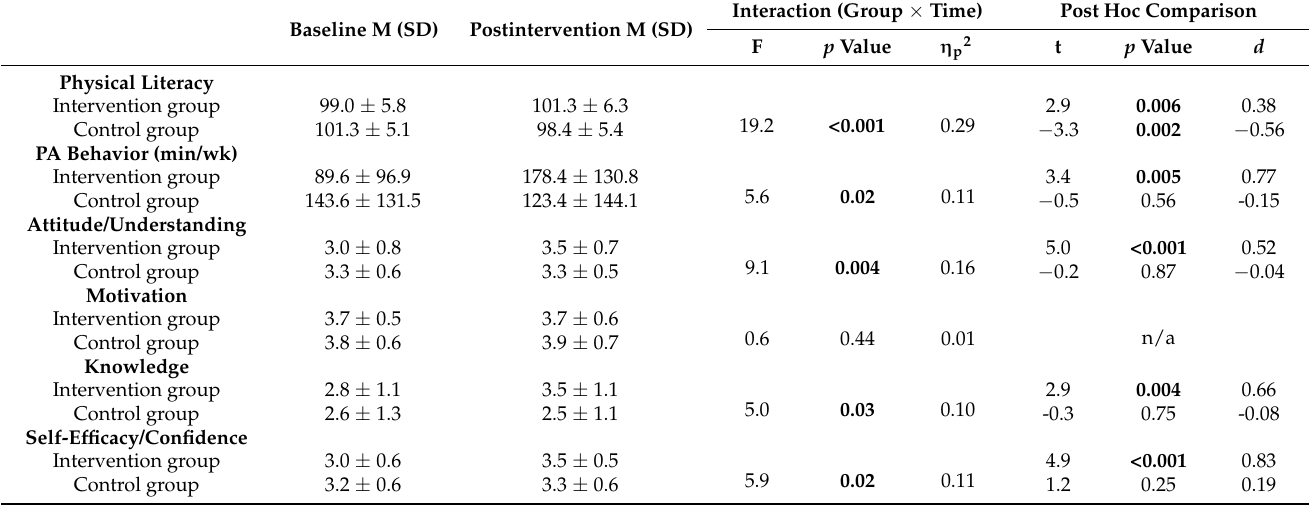
Table A1. Means (M) and standard deviations (SD) by time and condition and corresponding test statistics for the physical literacy composite and domain